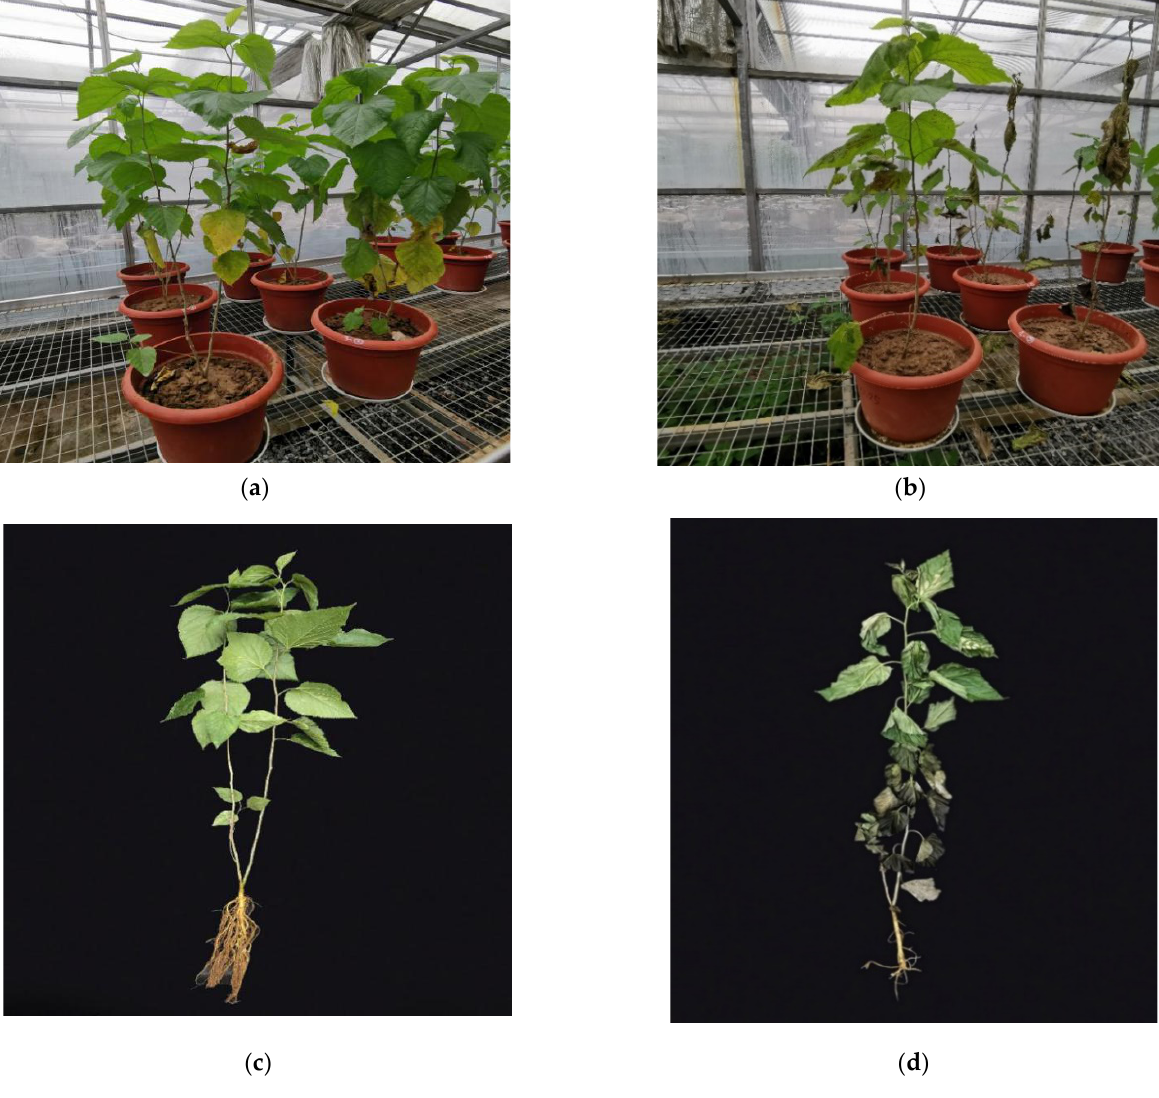
Figure 1. Injury phenotypes of salt stress in cycle 2. ( a ) Growing status of 0.3% on the 12th day. ( b ) Growing status of 0.4% on the 12th day. ( c ) Growing status of 0.3% on the 14th day. ( d ) Growing status of 0.4% on the 14th day.